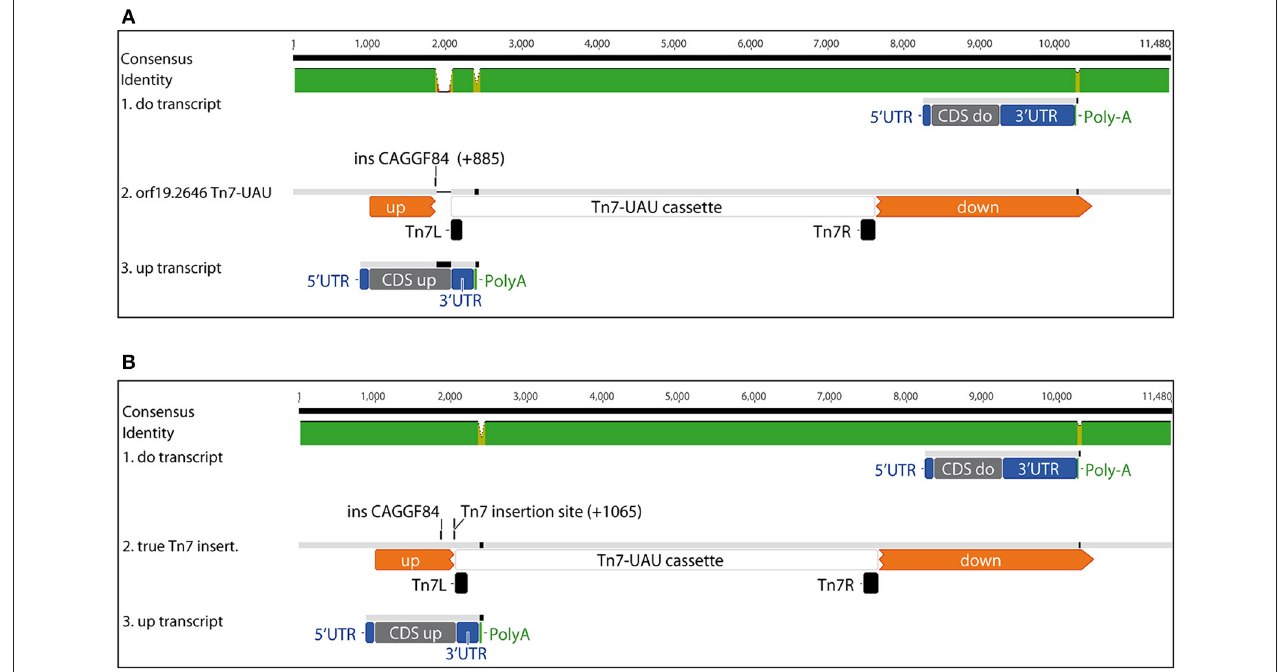
FIGURE 5 | Mapping of the upstream (up) and downstream (do) Tn7 transcripts. (A) Mapping of the reconstituted upstream and downstream transcript sequences on the CAGGF84 TIGR sequence, (B) Newly deduced sequence for the orf19.2646 Tn7-UAU insertion locus and alignment with the identified upstream and downstream